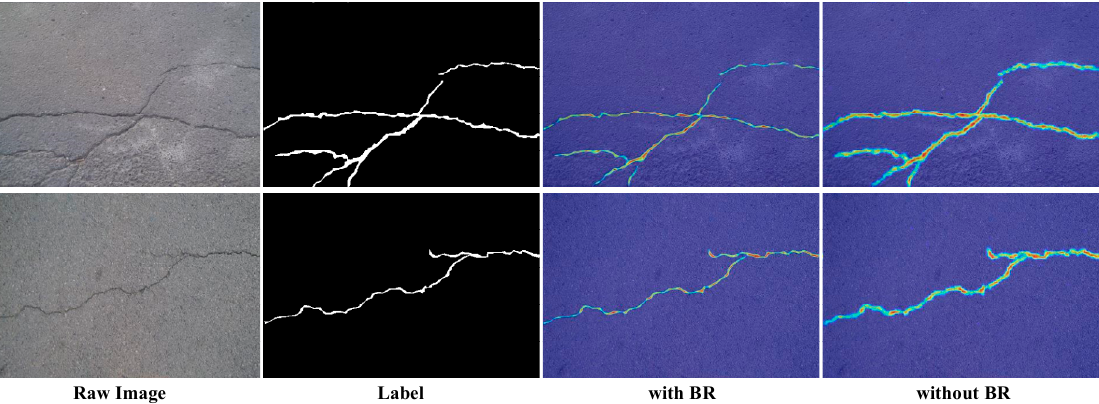
Figure 7. The visualization of feature heat maps during training with/without the proposed BR block.